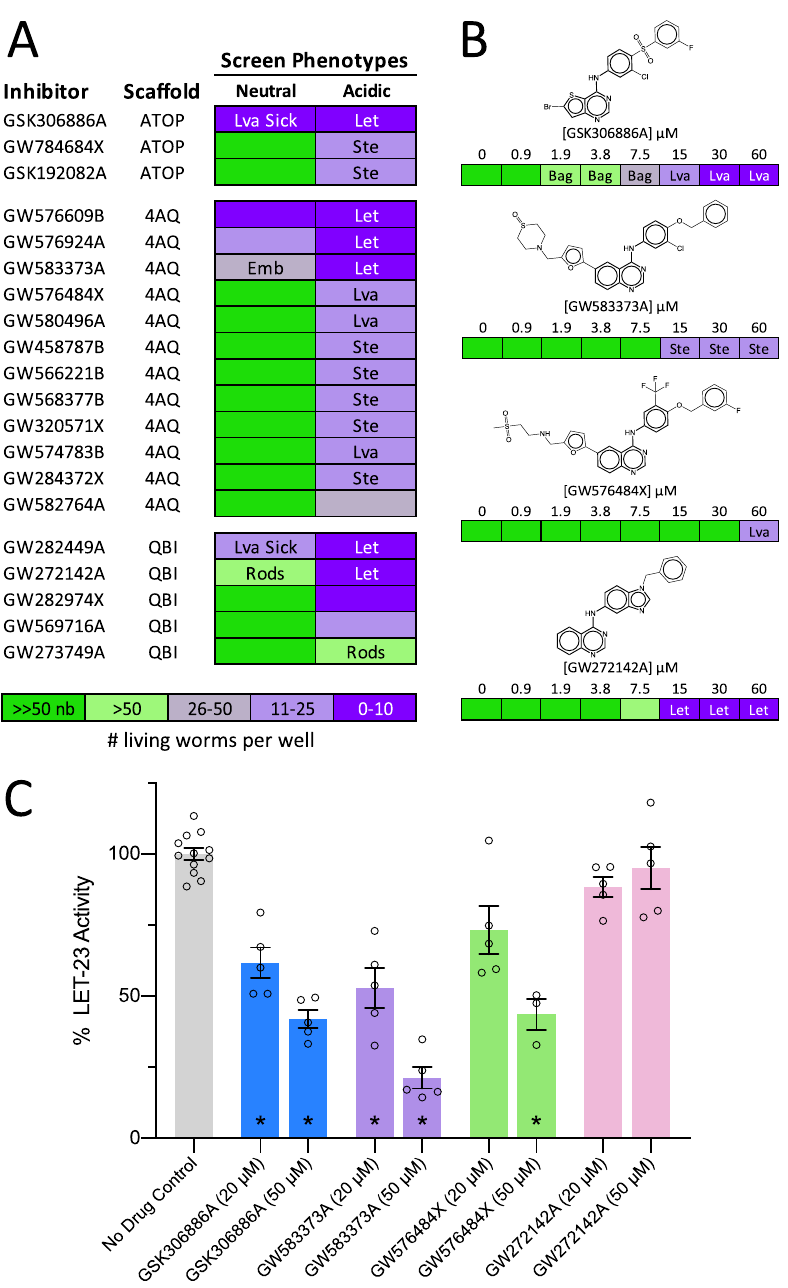
Figure 5. Three scaffolds induce LET-23 loss-of-function phenotypes in C. elegans. ( A ) The structurally related anilino thienopyrimidine (ATOP), 4-anilino quinazoline (4AQ), and quinazoline benzimidazole (QBI) scaffolds induce LET-23 loss-of-function phenotypes in our C. elegans chemical screens. ( B ) Exemplar worm-active structures from each scaffold are shown along with the associated dose–response in wild type C. elegans. These dose–response analyses reveal phenotypes relevant to EGFR/MAPK pathway inhibition including sterility (Ste) and the bag-of-worms phenotype (Bag). Additional phenotypes including lethality (Let) and larval arrest (Lva) are shown and the resulting population growth defects are indicated by the colour coded scale (nb, no bacteria remaining in the well). Dose–response analyses for GSK306886A and GW583373A were performed in neutral media, GW576484X and GW272142A in acidic media. ( C ) Four worm-active inhibitors were tested for their ability to inhibit C. elegans LET-23 kinase activity in vitro . LET-23 inhibition is expressed as a the percentage of total kinase activity observed in no drug controls averaged across 3–5 replicates for each inhibitor condition. The ATOP and 4AQ scaffold compounds tested were able to inhibit LET-23 kinase activity (Student’s T-test; * p < 0.01). Error bars indicate